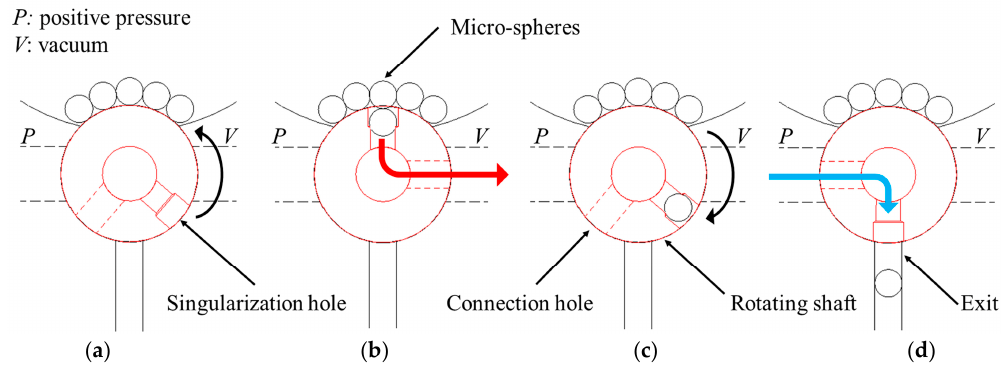
Figure 1. Operating principle of the innovative singularization mechanism (cross-section; dashed lines indicate the holes on a back plane): ( a ) top positioning phase; ( b ) isolation phase; ( c ) bottom positioning phase; and ( d ) exit phase.